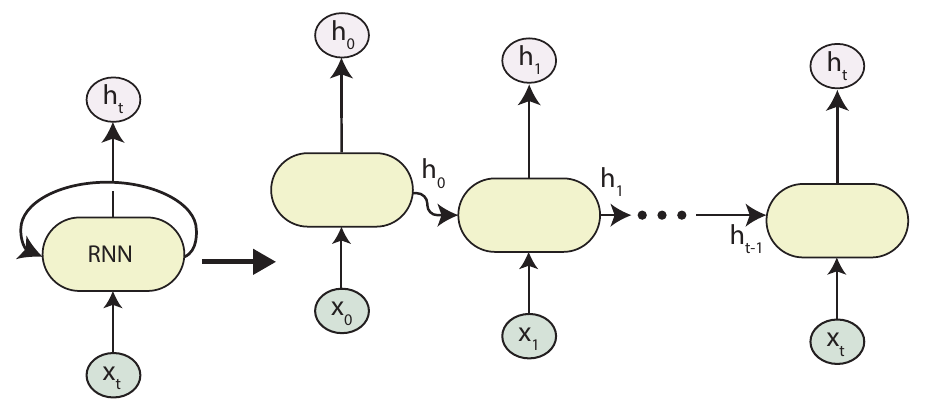
Figure 4. Folded and Unfolded RNN.